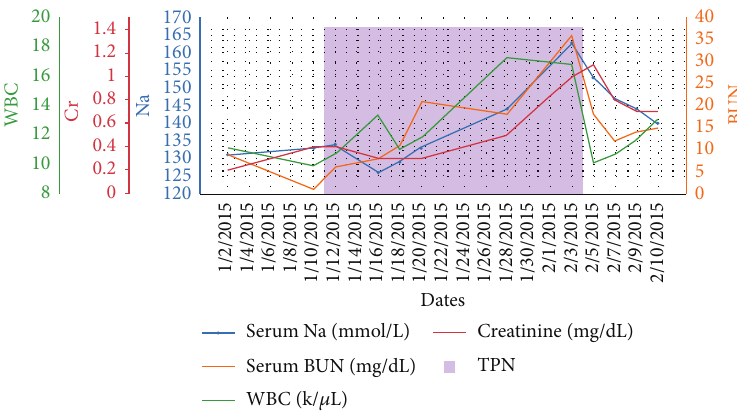
Figure 3: Correlation of serum Na, BUN, WBC, Cr, and